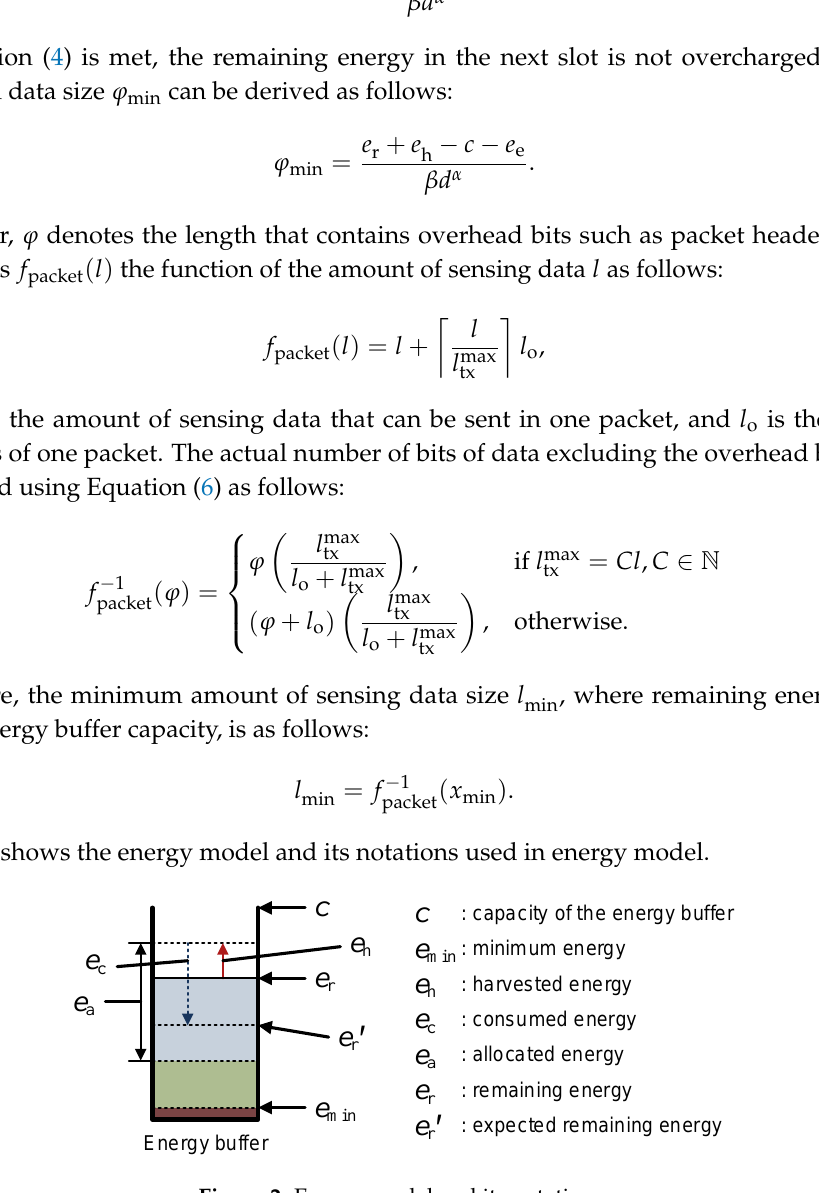
Figure 2. Energy model and its